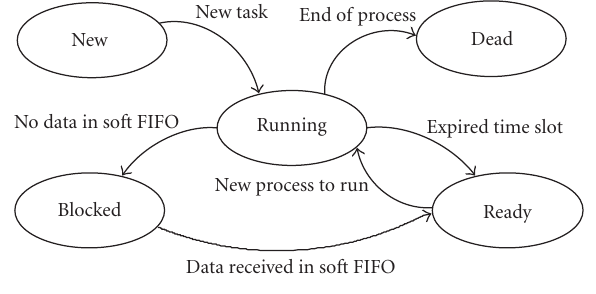
Figure 7: Task state